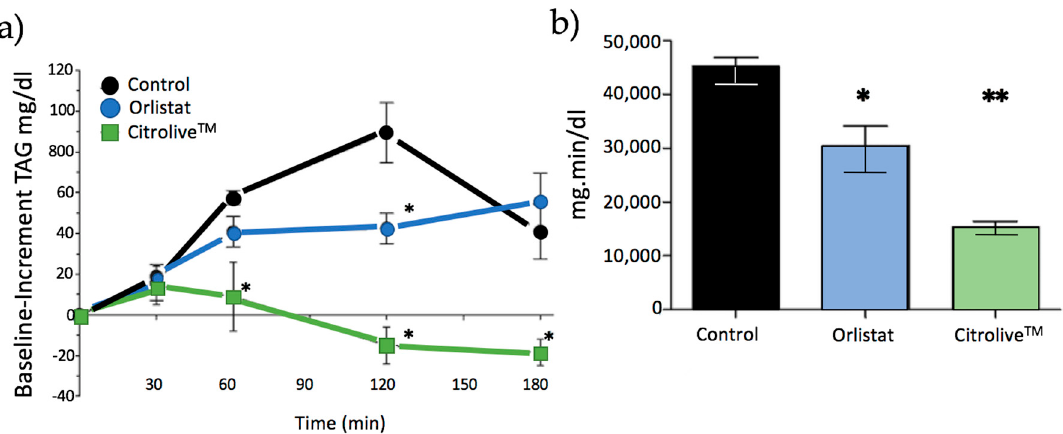
Figure 2. ( a ) Postprandial plasma TAG levels of the different oil-based emulsion vehicles during 180 min after their administration. The values were expressed as increment from basal TAG values (TAG mg/dL increment mean ± SD, n = 6). Stars indicate that the values were significantly different ( p < 0.05 with *); ( b ) Area under the curve (AUC) of the test compounds. Stars indicate that the values were significantly different ( p < 0.05 with *; p < 0.01 with **).